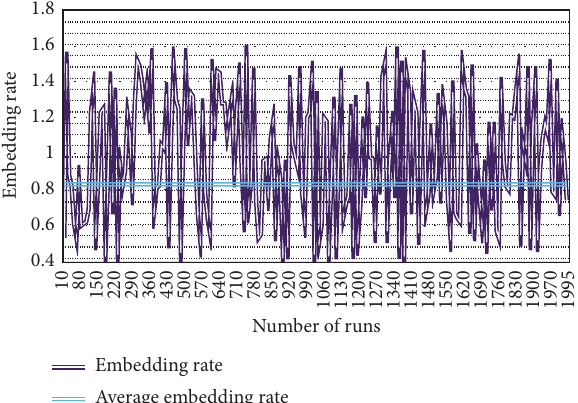
Figure 7: Schematic diagram of secret information embedding rate results with a length of 40